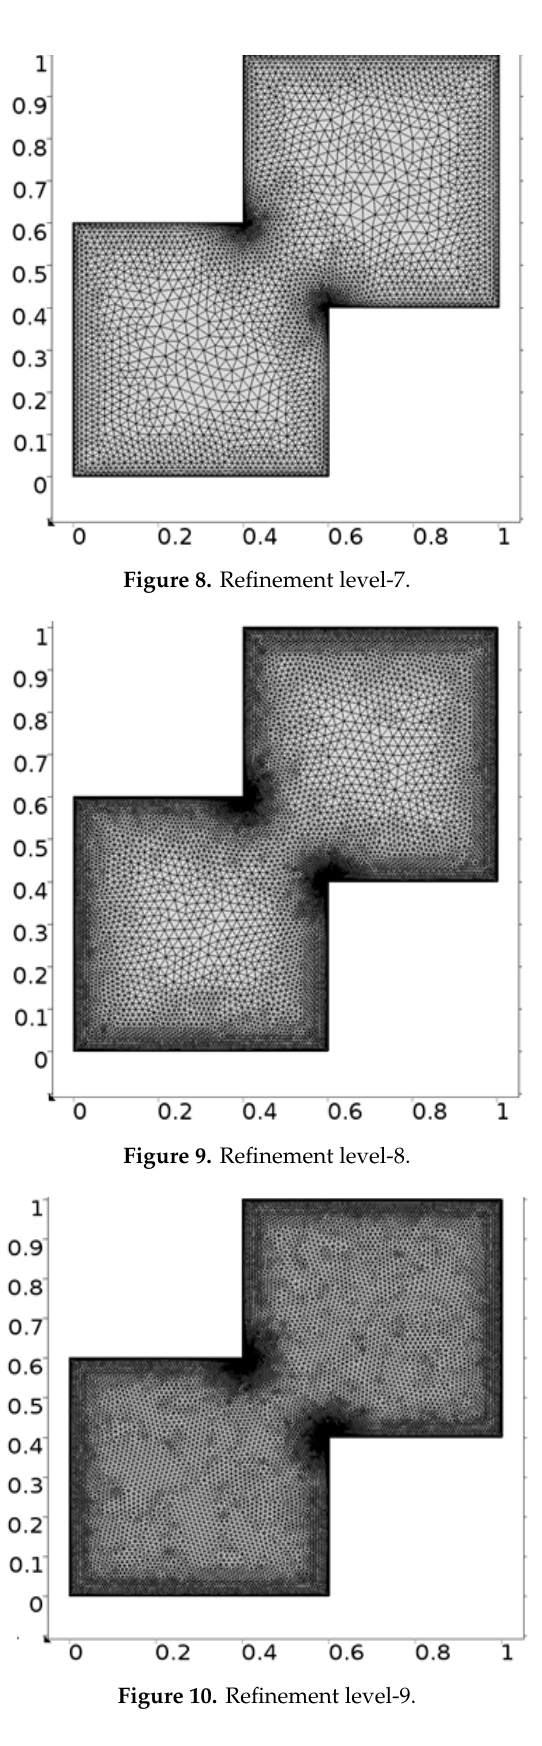
Figure 10. Refinement level-9.